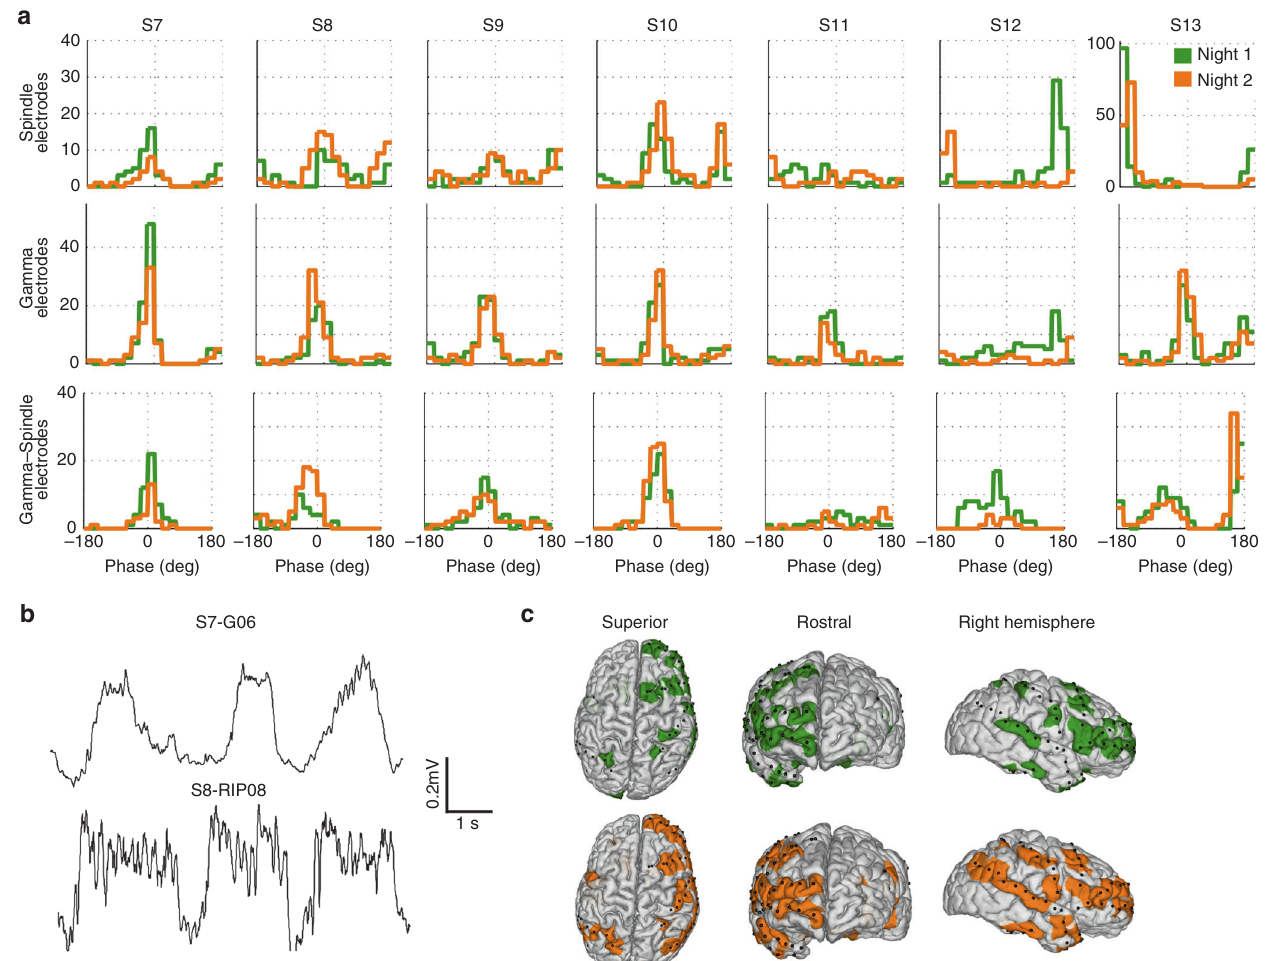
Fig. 3 PAC of fast spindle and gamma activity to the phase of endogenous slow oscillation. a Histogram of the mean preferred phase (of 1 Hz bandpassed signal) across electrodes with signi fi cant PAC for two different nights (Night 1, green; Night 2, orange). Each histogram corresponds to a different subject. 0° corresponds to the positive phase of the raw iEEG traces, +/ − 180° corresponds to the negative phase. The upstate is characterized by increased fast spindle (14 Hz) and increased gamma (70 – 110 Hz) activity. Electrodes with increased spindle/gamma activity in the positive phase (0°) are mostly cortical, and those with increase in the negative phase (180°) are mostly depth electrodes, which is consistent with previous reports 35, 49 . b Examples with spindle activity occurring with the positive phase of the slow-wave cycle as seen in the raw iEEG traces for two representative cortical electrodes (subject S7, electrode G06l; subject S8, electrodes RIP08). c Locations of cortical electrodes with signi fi cantly PAC of fast spindle activity for S8. Night 1 (top row, green) and night 2 (bottom row, orange) show widespread and consistent entrainment across nights. Left to right: top view, frontal view, right view. Black dots indicate the locations of the subdural grid